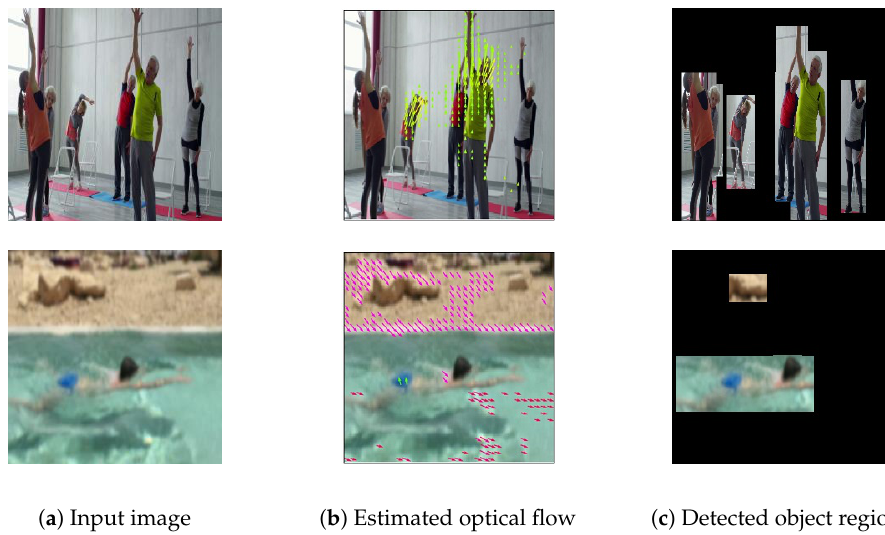
Figure 5. Flow visualization for Figure 5: ( a ) input image, ( b ) optical flow estimated by CNN estimate , and ( c ) detected object regions. Following [11], we use same color coding to visualize flow for most viewed.